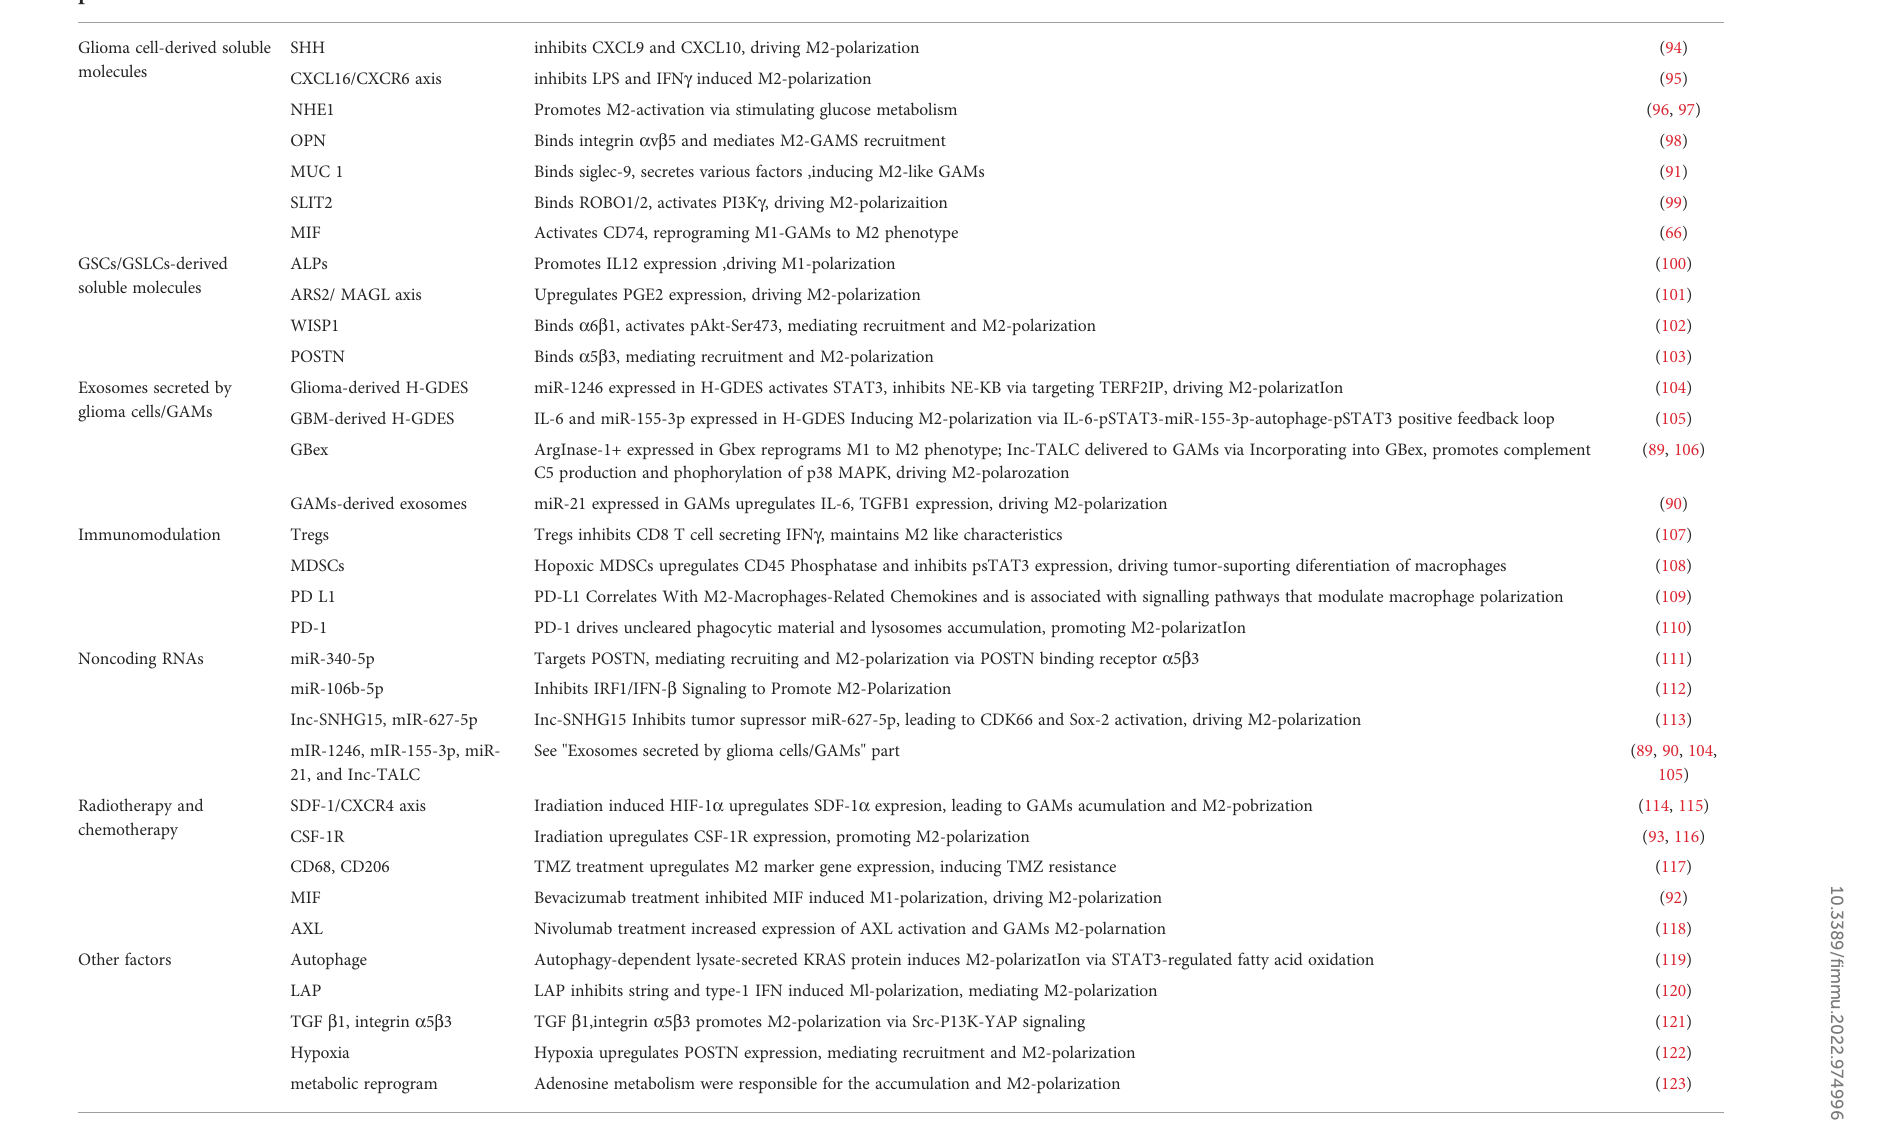
TABLE 1 Regulators of M1/M2-GAMs activation and